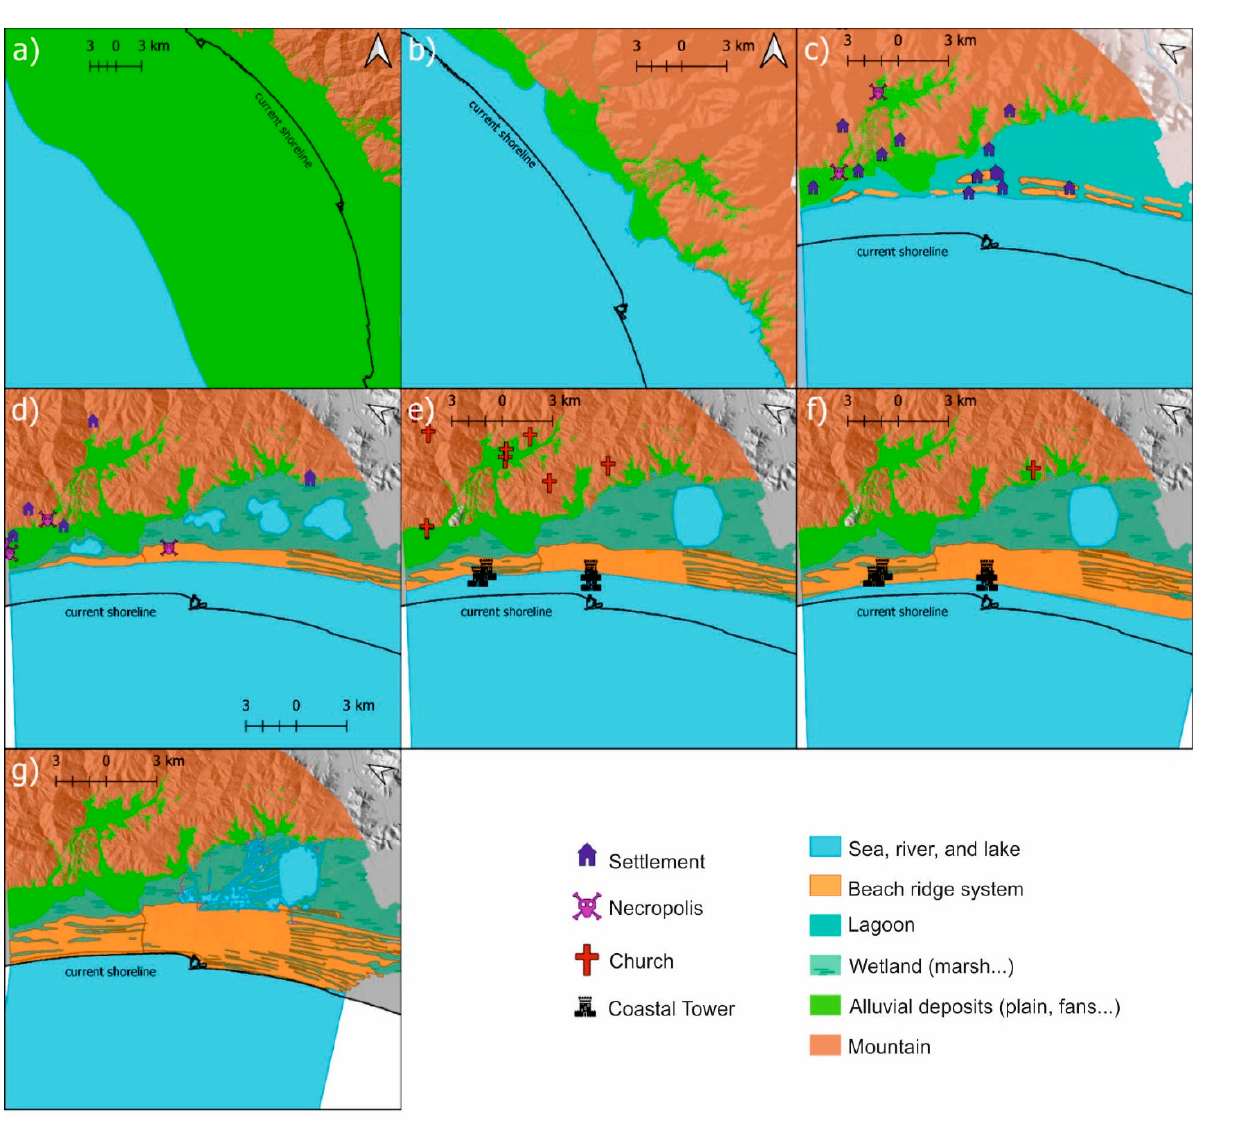
Figure 3. Reconstruction of the palaeoenvironment of a) about 20,000 years B.P., b) about 7,000 years B.P., c) Etruscan Age, d) Roman Age, e) Middle Ages, f) Modern Age and g) Contemporary Age.